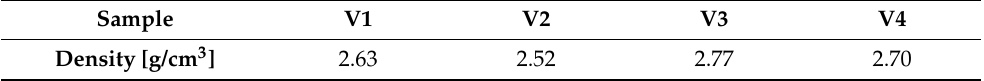
Table 3. Briquette density evaluated on the basis of mass and dimension measurements.